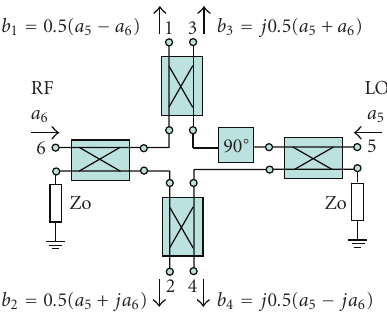
Figure 1: The simplified block diagram of a multiport circuit for down-conversion.